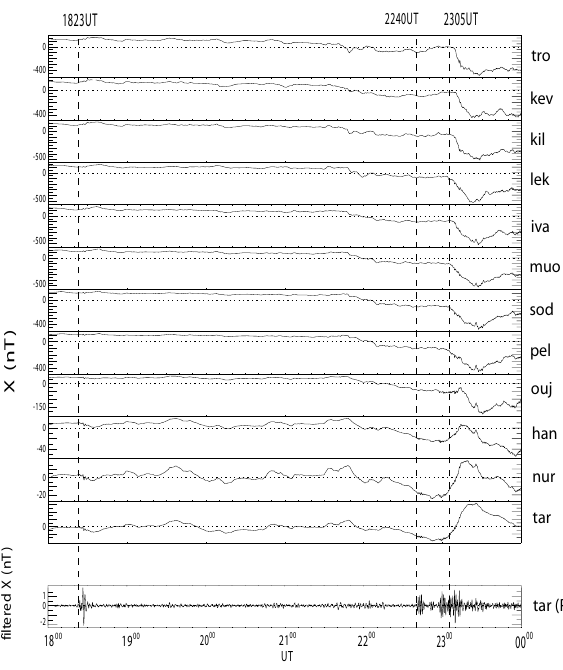
Fig. 3. Top panels: x -component of magnetic fields at selected IM- AGE magnetometer stations; bottom panel: x -component filtered magnetometer data from one example station in the period band